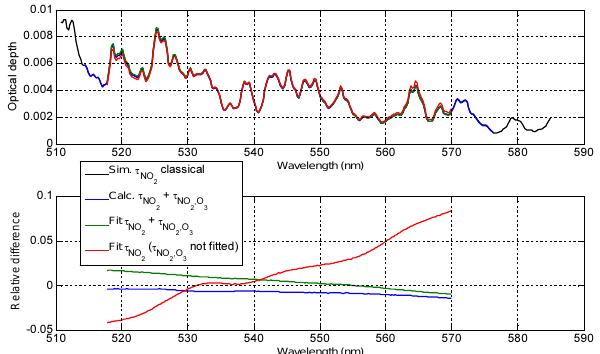
Figure 10. Results of the Taylor series DOAS evaluation either with or without the cross-correlative ozone and NO 2 term included in comparison with the NO 2 OD simulated according to the classical definition (Eq. 27) and calculated from the simulated effective light paths (up to the second order). Top: absolute values of the simulated, calculated, and retrieved OD for NO 2 ; bottom: relative difference with respect to the classical